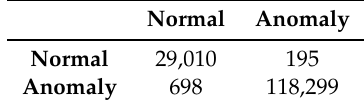
Table 19. Confusion matrix for Bagging Reptree.